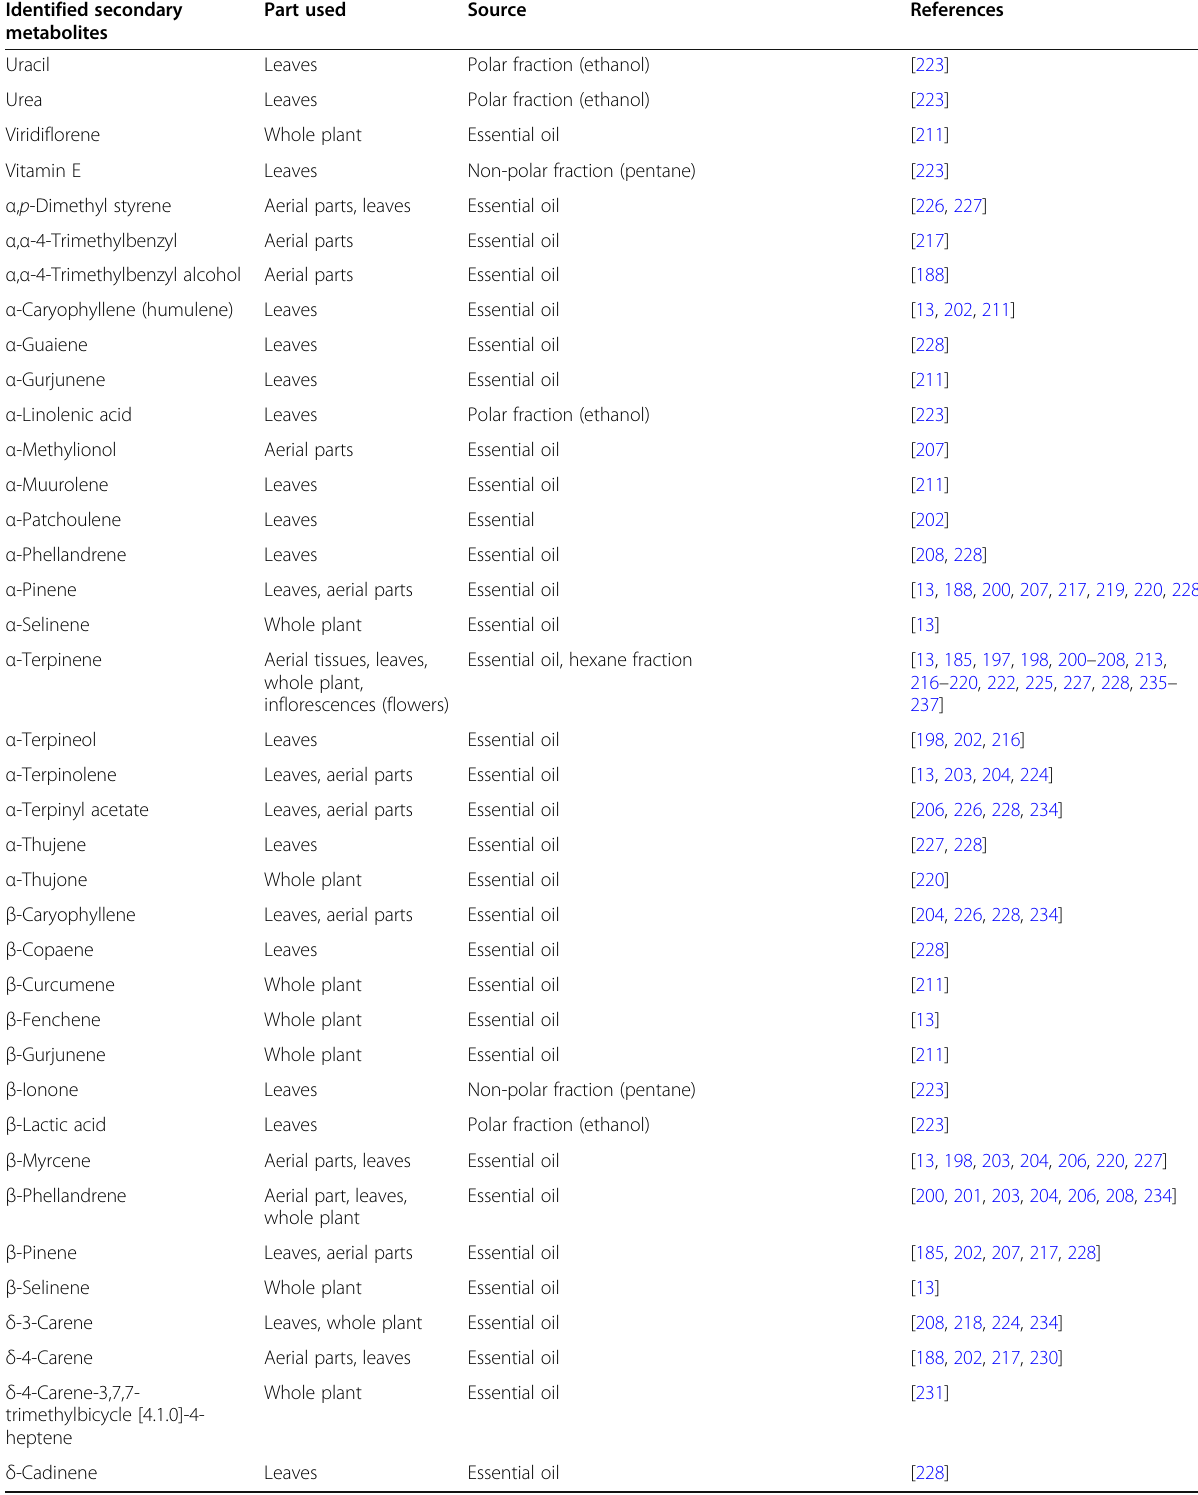
Table 3 Main secondary metabolites identified in C. ambrosioides